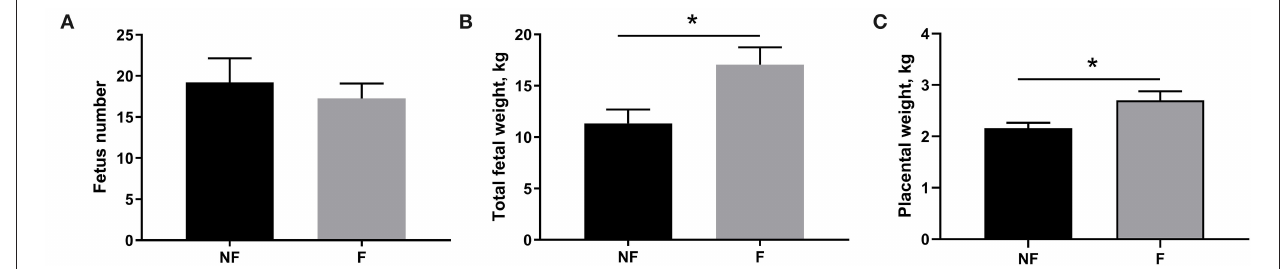
FIGURE 1 | Effects of fiber supplementation in gestating sow diet on fetus number, fetal weight, and placental weight. (A) Fetus number; (B) Total fetal weight; (C) Placental weight. NF, sows fed with a semi-purified basal diet (0.01% dietary fiber); F, sows fed with a semi-purified basal diet supplemented with 8.33 g/kg inulin and 200 g/kg cellulose. Values are mean ± standard error ( n = 5). Significant differences are displayed in the figures by * P < 0.05.